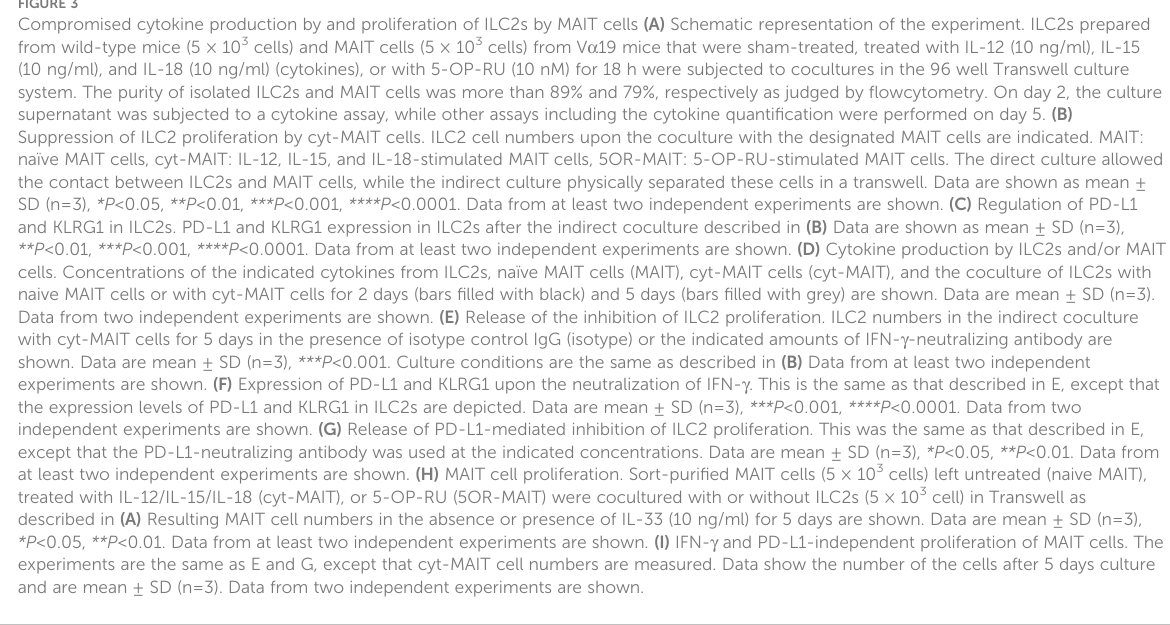
**P <0.01, ***P <0.001, ****P <0.0001. Data from at least two independent experiments are shown. (D) Cytokine production by ILC2s and/or MAIT cells. Concentrations of the indicated cytokines from ILC2s, naïve MAIT cells (MAIT), cyt-MAIT cells (cyt-MAIT), and the coculture of ILC2s